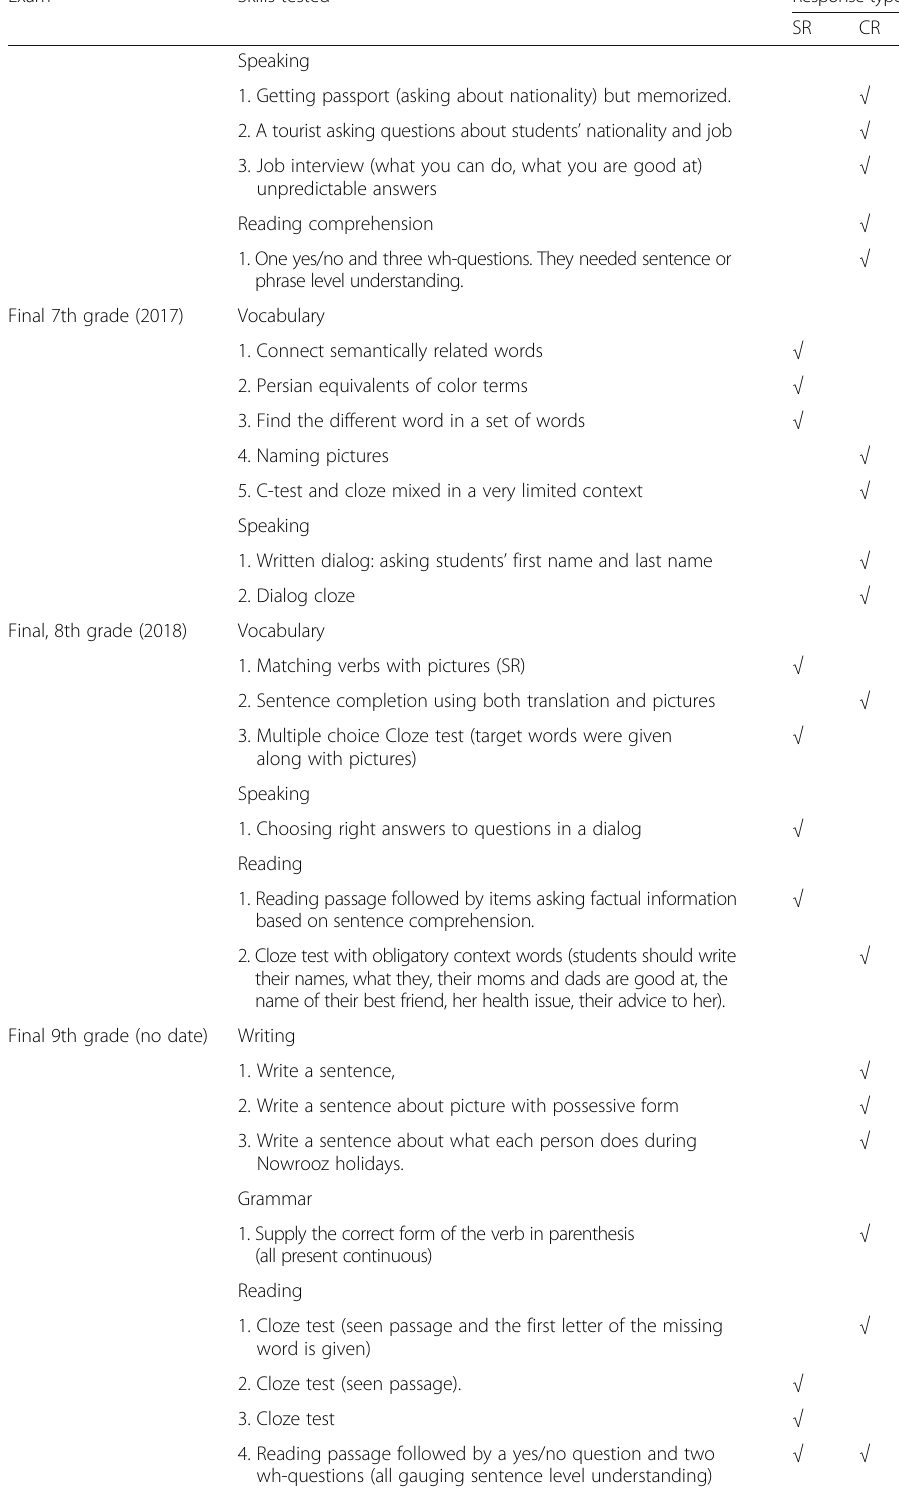
Table 3 Content analysis of tests